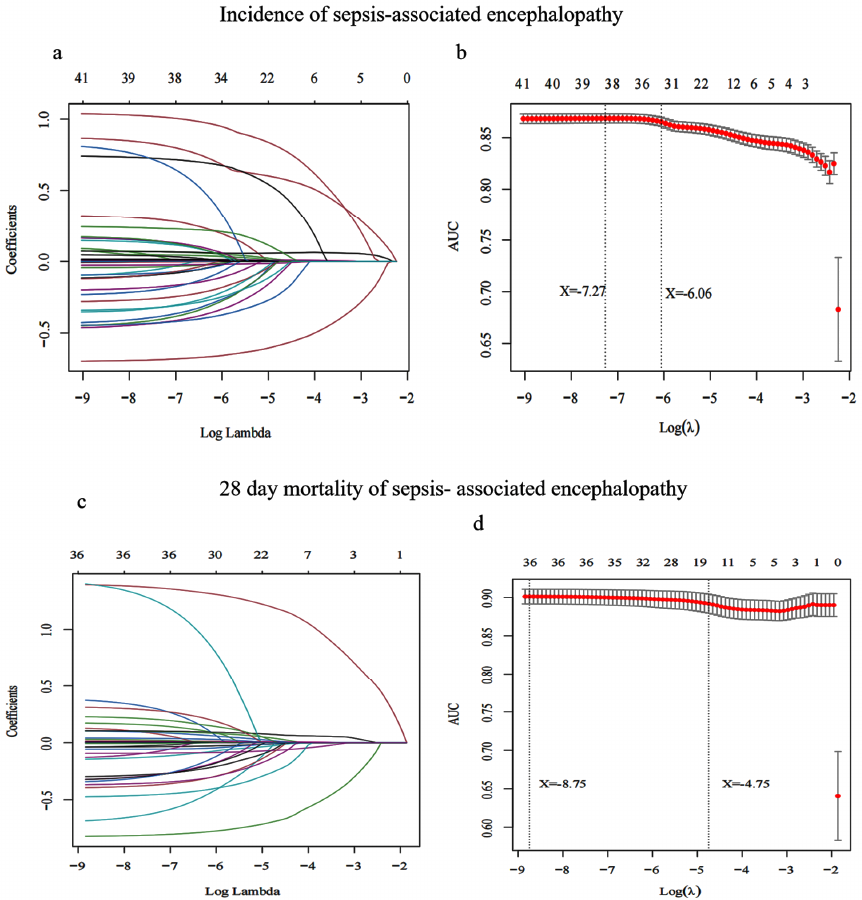
Figure 2. LASSO regression was used to screen the characteristic variables associated with the incidence and 28-day mortality of sepsis-associated encephalopathy. ( a , c ) The punishment to the model increases with an increase in the log lambda value, such that fewer variables are included in the model. ( b , d ) The dotted line on the left indicates the inclusion of independent variables in the minimum model, while the dotted line on the right indicates the inclusion of independent variables in the most streamlined model.